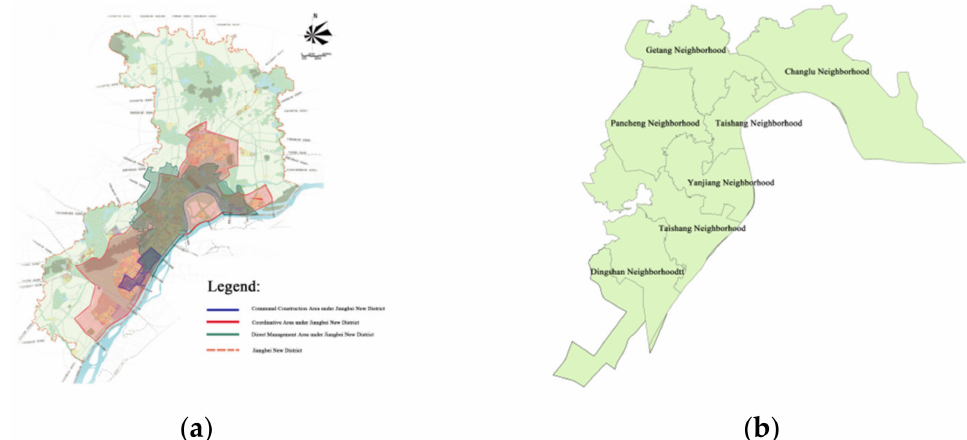
Figure 1. ( a ) Administrative divisions of Jiangbei New District; ( b ) Administrative divisions of Direct, Management Area (Luhe District, Direct Management Area, Pukou District, Coordinative Area under Jiangbei New District, Communal Construction Area under Jiangbei New District, Direct Management Area under Jiangbei New District, Center of Jiangbei Downtown; Yanjiang Neighborhood, Taishang Neighborhood, Pancheng Neighborhood, Dachang Neighborhood, Changlu Neighborhood, Dingshan Neighborhood, Getang Neighborhood).